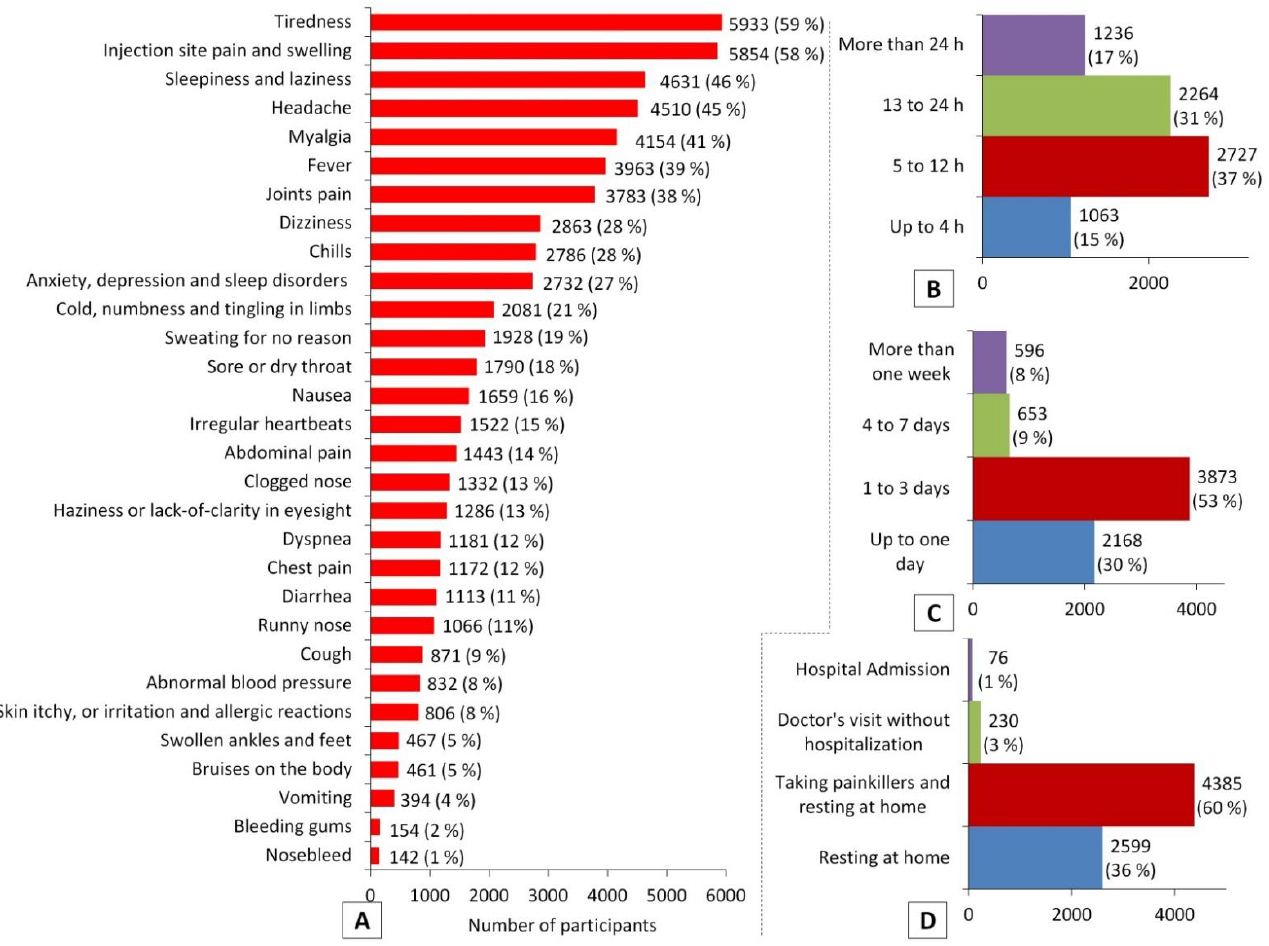
Figure 4. Side effects of COVID-19 vaccines. ( A ), the most common post-vaccination side effects; ( B ), interval between receiving a COVID-19 vaccine and experiencing side effects; ( C ), duration of post-vaccination side effects; ( D ), coping responses to post-vaccination side effects.